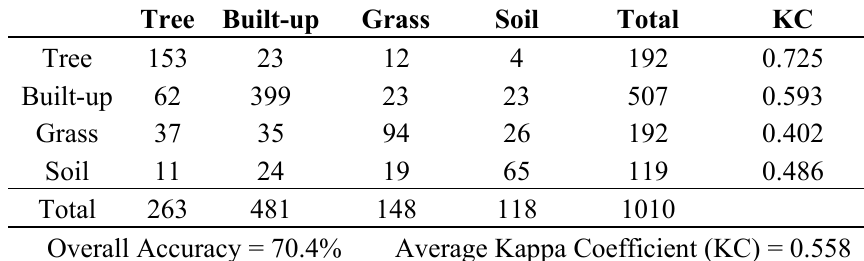
Table 7. Confusion matrix of the classification result using geometrically calibrated and radiometrically corrected LiDAR dataset.